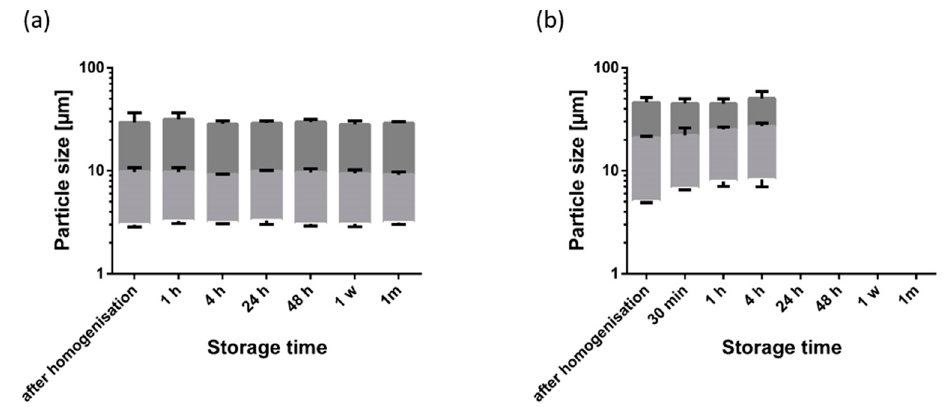
Figure 9. Particle size distribution of oleogels (8% TE in paraffin) during one month of storage with ( a ) 2% 1,2-hexanediol and ( b ) 2% 1,6-hexanediol; mean ± SD, n = 3.